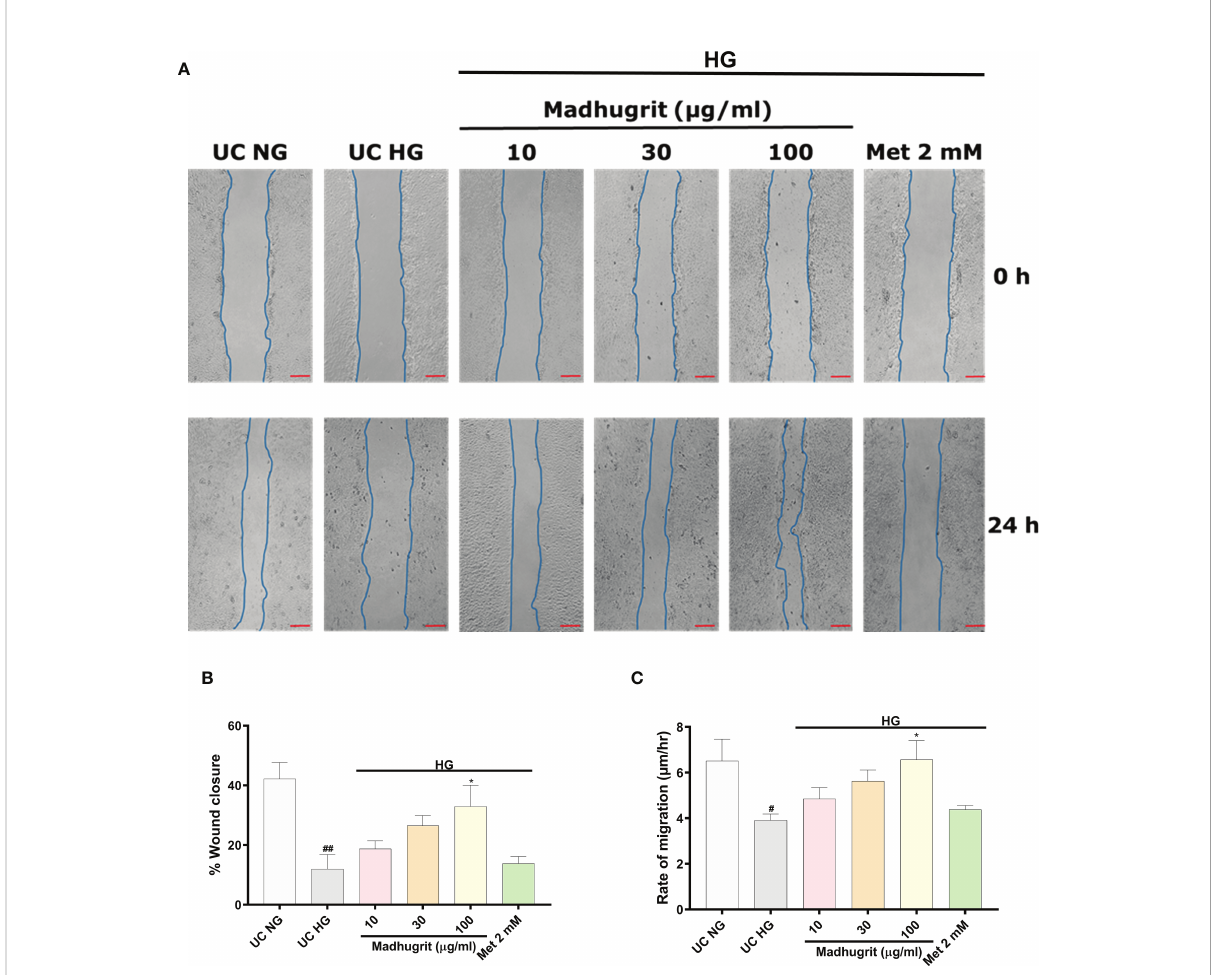
FIGURE 6 Madhugrit enhanced keratinocyte (HaCaT) migration capacity. (A) Representative pictures of scratched wound of HaCaT monolayers (0 and 24 hr) placed in normal glucose (NG) or high glucose (HG) conditions in presence of Madhugrit (10, 30, and 100 µg/ml) or Metformin (2 mM). Blue lines represent wounded area. Scale bar (red) = 100 µm. (B, C) Graph quantifying the average wound closure and rate of migration of the wounded HaCaT cells in presence of Madhugrit (10, 30, and 100 µg/ml) or Metformin (2 mM). The statistical signi fi cance of the observed differences in the means compared to the UC NG group was analyzed through one-way ANOVA followed by Dunnett ’ s multiple comparison test and represented as # (p<0.05) or ## (p<0.01). Comparison of the treatments with UC HG group was represented as *